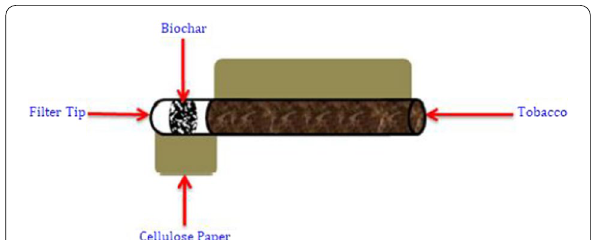
Fig. 2 Cigarette rod treated with C. megalocarpus seed husk biochar—Modified from Jebet et al. (2017)